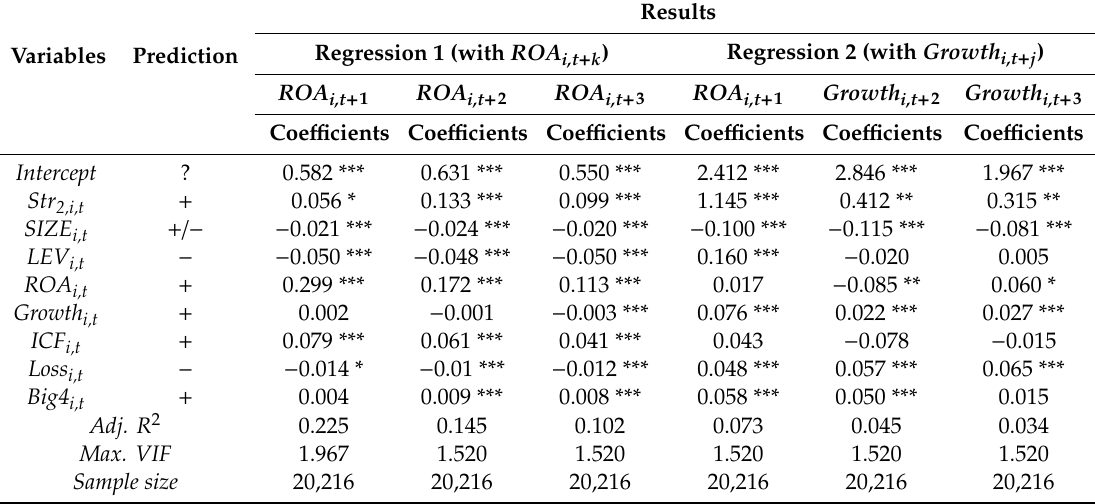
Table 7. Regression of future performance ( ROA i,t + k ) and growth sustainability ( Growth i,t + j ) on new product development ( Str 2, i,t ) a